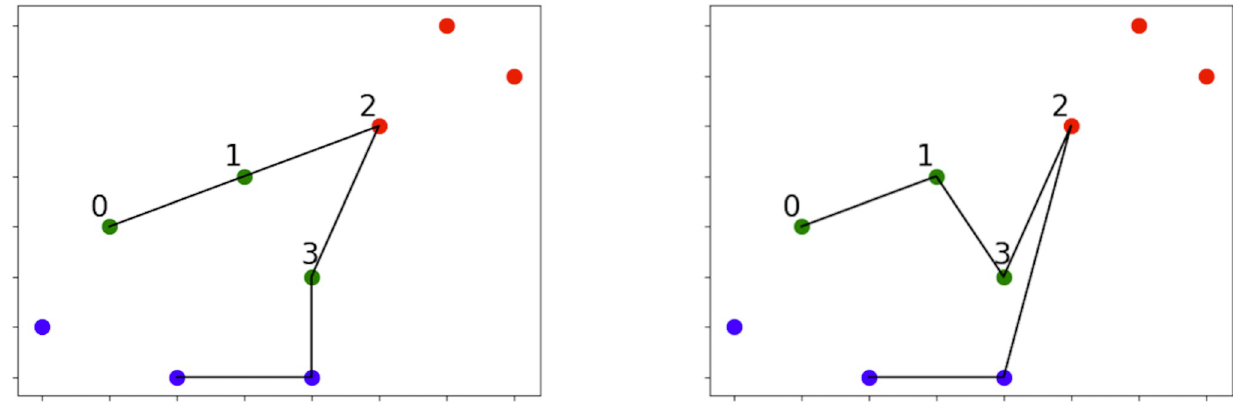
Fig 3. Pitfalls of merging only considering end-points. (Left) Optimal solution of a 9-sites OP. (Right) Solution to the same OP obtained by first decomposing the point set into three clusters. The clusters are highlighted by the different color points. The solution path is the result of merging the solutions from the three clusters using their path